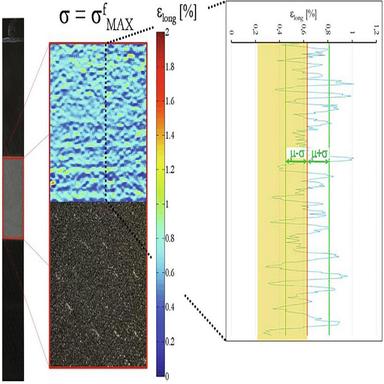
DIC strain field on virgin specimen. Analysis and quantification of noise.